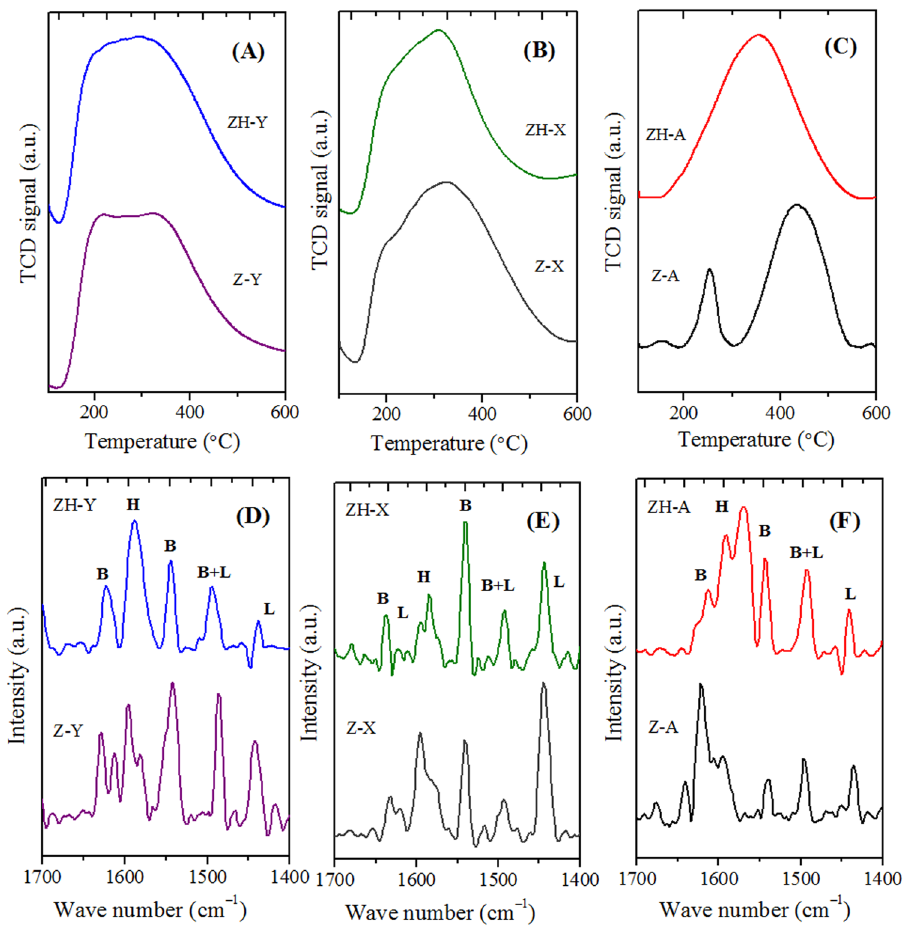
Figure 10. NH 3 -TPD traces ( A – C ) and pyridine DRIFT spectra ( D – F ) of various